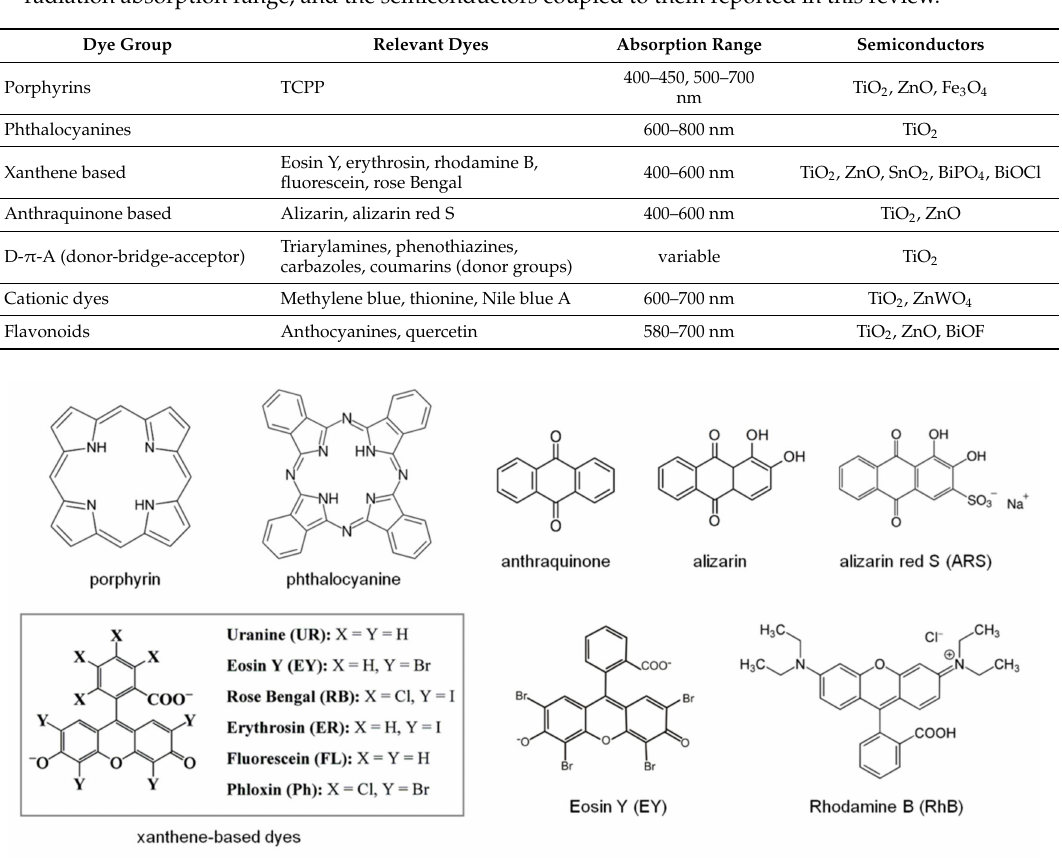
Figure 2. Molecular structures of di ff erent dyes commonly employed as sensitizers in photocatalysis. Adapted and reprinted with permission from [15], Copyright (2016)